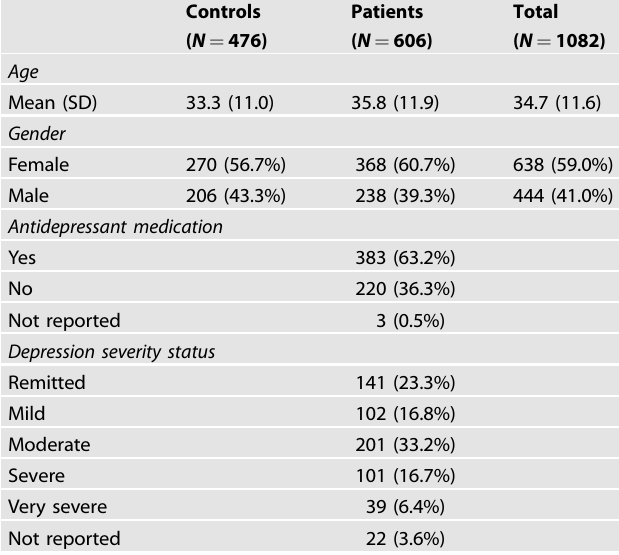
Table 1. Demographic information of the included study participants.